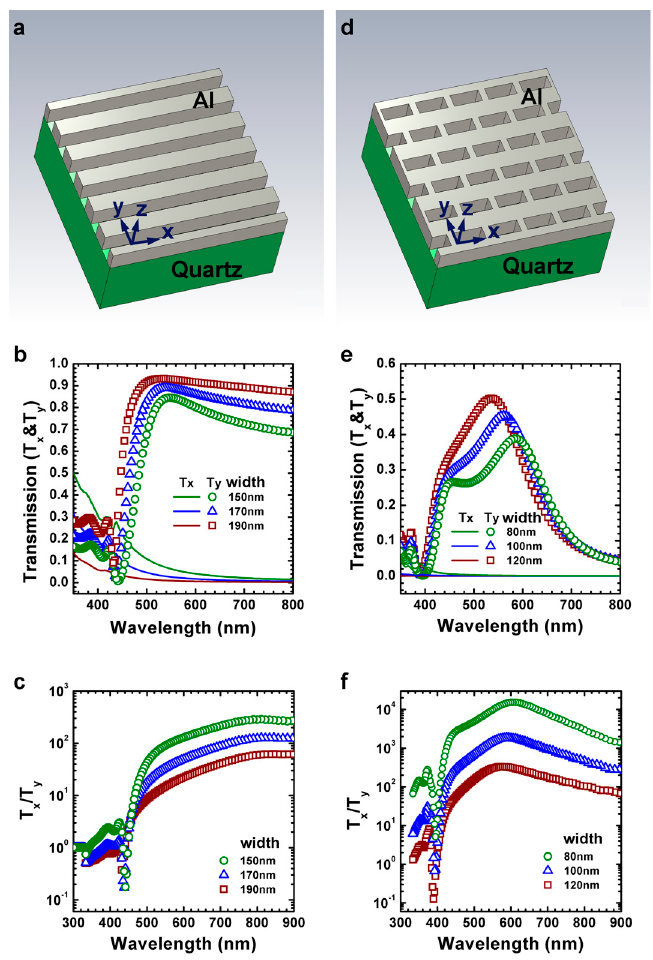
Figure 1. ( a ) Schematic plasmonic metamask (PMM) based on nanoslit arrays; ( b , c ) Simulated optical transmittance ( b ) and polarization ratio ( c ) versus wavelength for wire grid polarizer with three different slit widths: 150 nm, 170 nm, 190 nm. The period is set at 300 nm, and the mask film thickness is 150 nm; ( d ) Schematic PMM based on rectangular nanoapertures on a triangular lattice; ( e , f ) Simulated spectra for optical transmittance ( e ) and polarization ratio ( f ) for nanoaperture-based PMM with three different aperture widths. The mask is of 150 nm in thickness and 270 nm in period. The nanoaperture length is 200 nm, and width is varied: 80 nm, 100 nm, 120 nm.